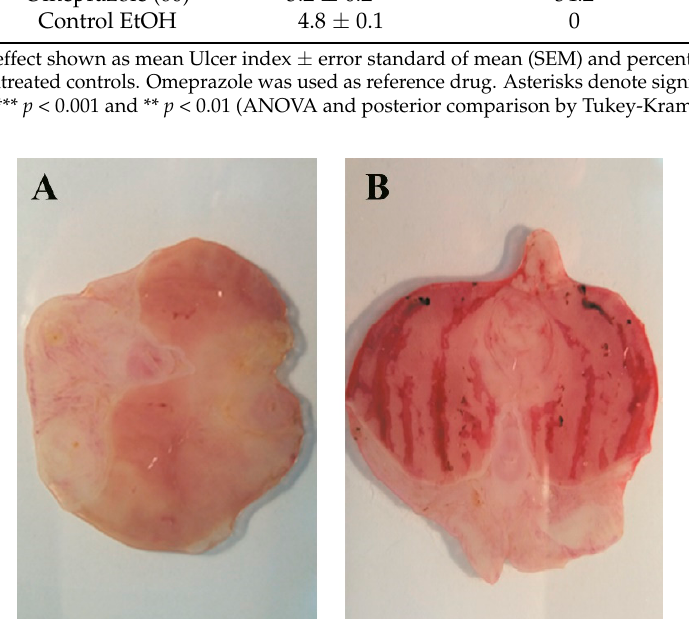
Figure 1. Effects of BLD at 750 mg/kg ( A ) on the macroscopic aspect of stomach in ethanol-induced gastric lesions in rats ( B ).